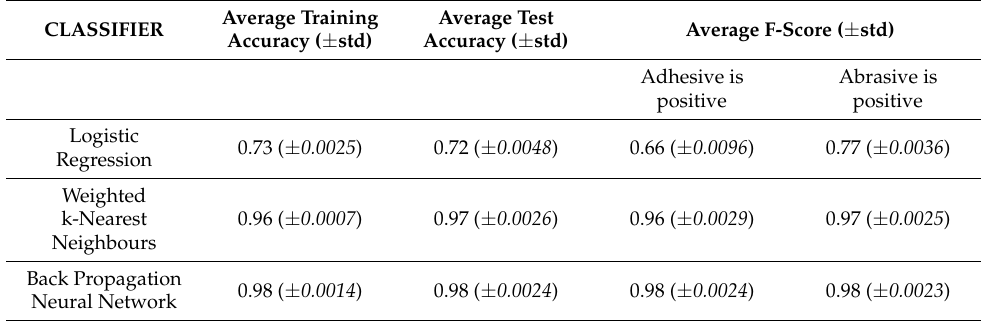
Table 5. Summary of classifiers’